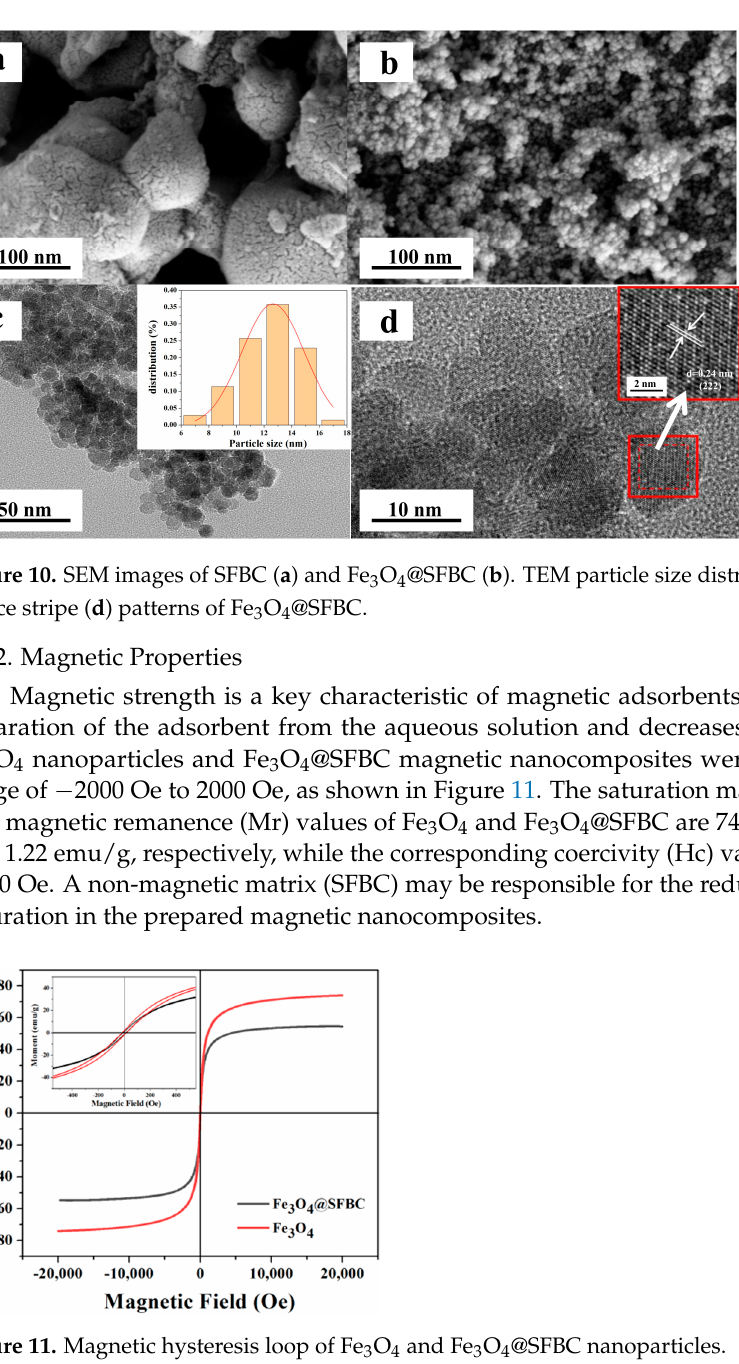
Figure 11. Magnetic hysteresis loop of Fe 3 O 4 and Fe 3 O 4 @SFBC nanoparticles.